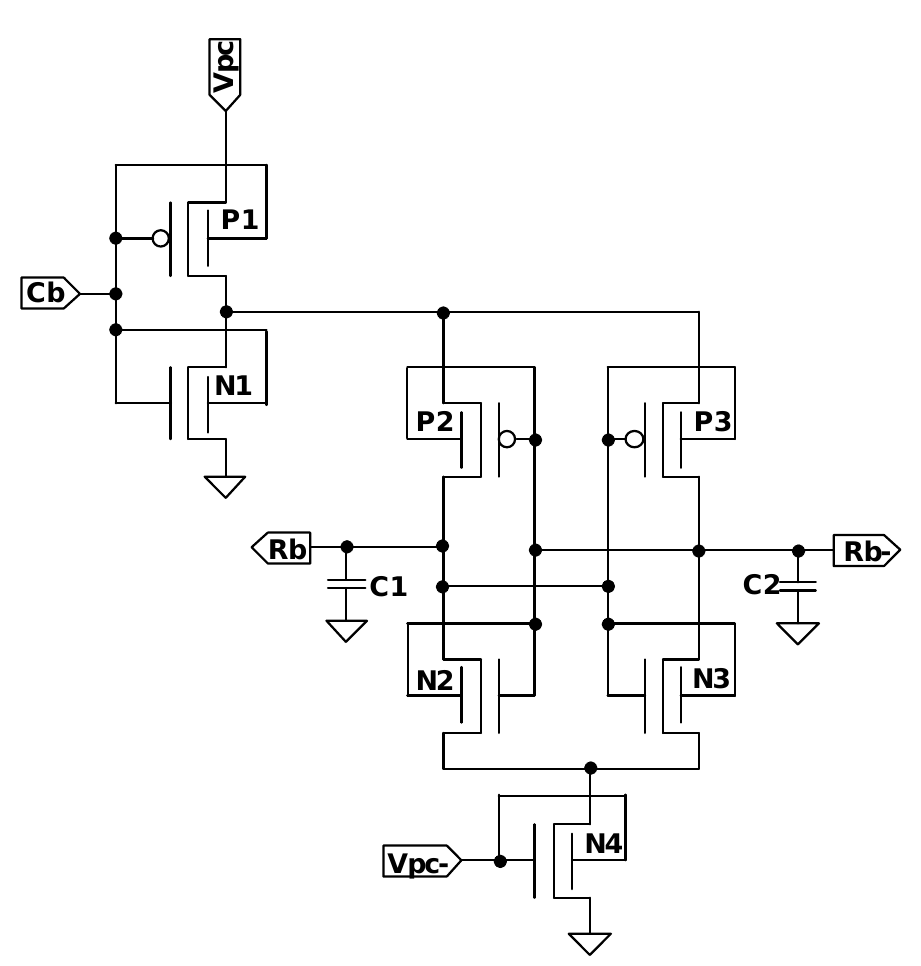
Figure 4. Proposed SRAM-based FinFET TPCA-PUF circuit.